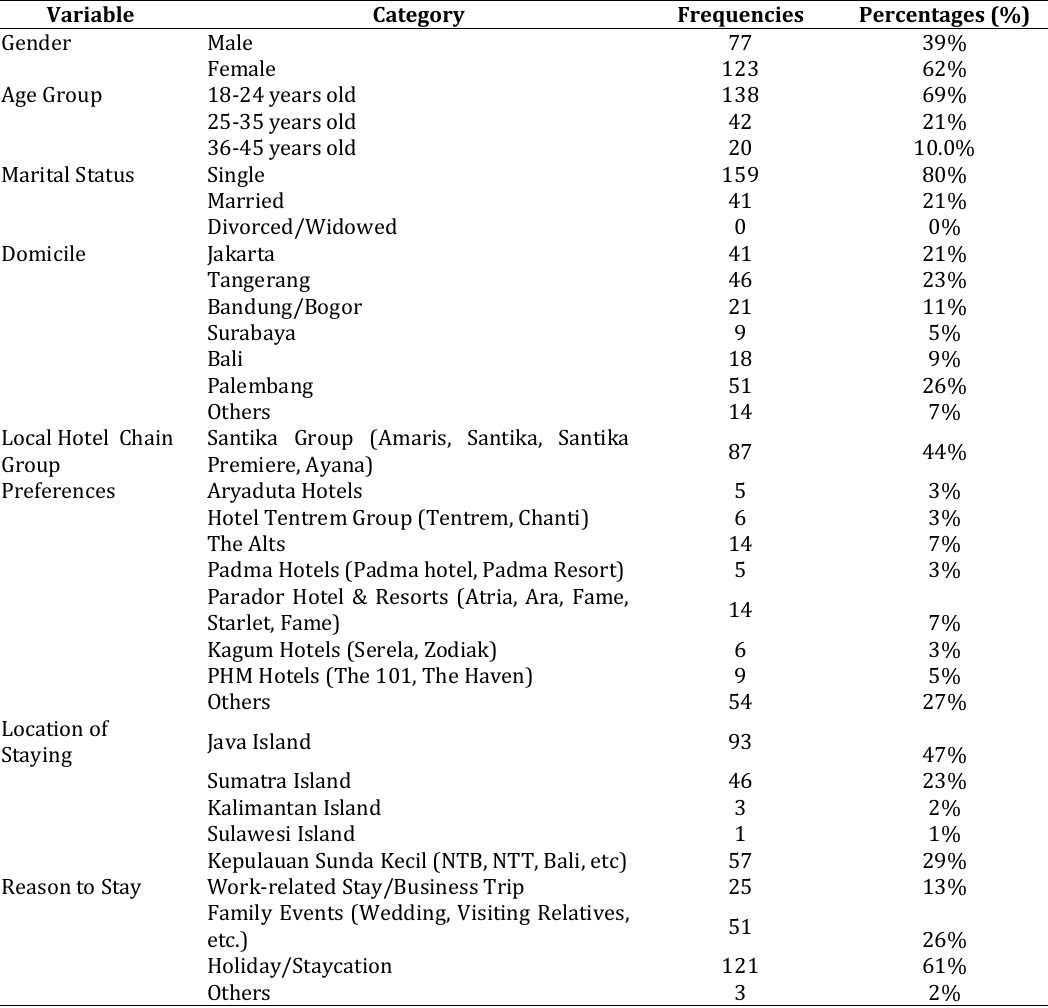
Table 2: Demographics of subjects in local chain hotel